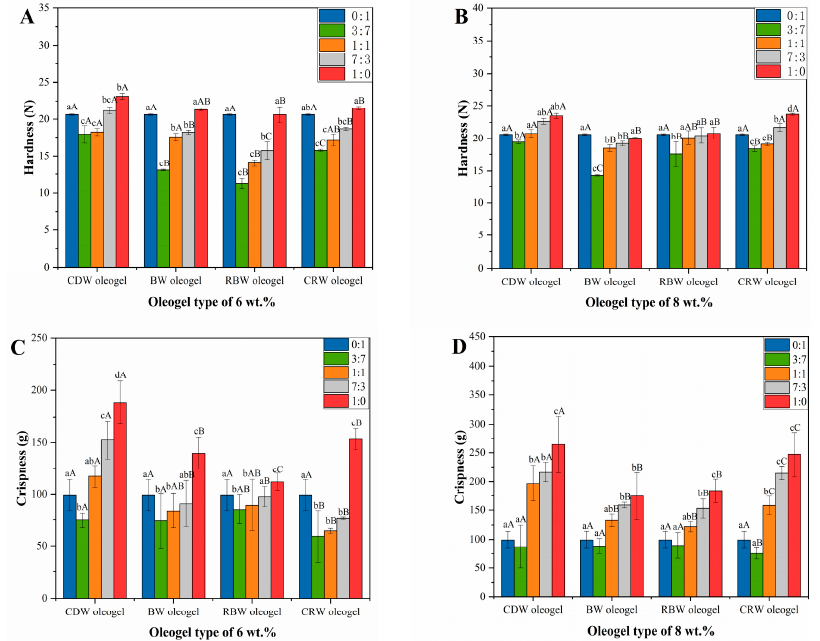
Figure 5. ( A , B ) Hardness of cookies prepared by replacing shortening with 6 and 8 wt.% CDW, BW,